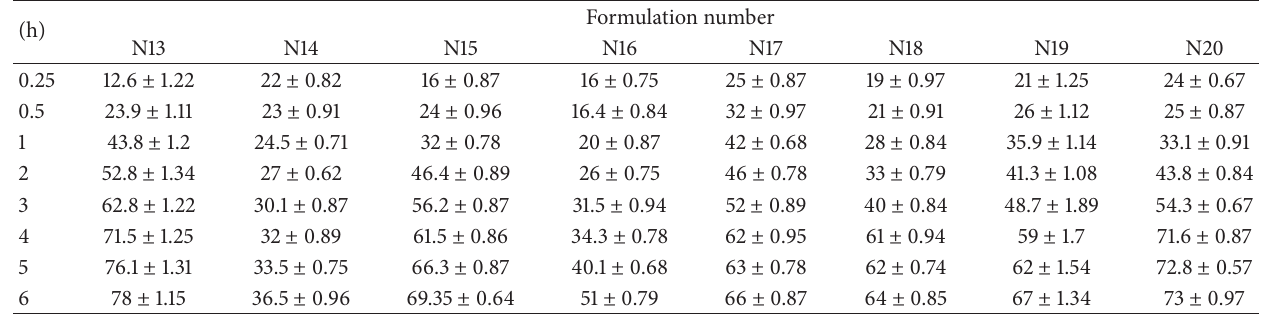
Table 6: Naftifine hydrochloride release, polymer Eudragit RS100.